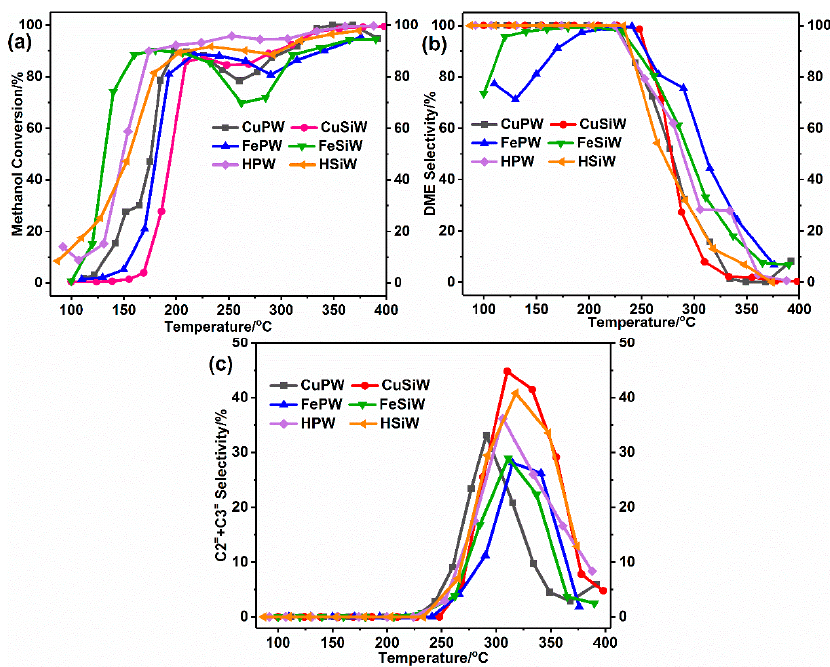
Figure 5. Effluent distribution of temperature programmed conversion of methanol on heteropolyacid salts and heteropolyacids. ( a ) CuPW, ( b ) CuSiW, ( c ) FePW, ( d ) FeSiW, ( e ) HPW, ( f ) HSiW, m cat = 3.00 g, N 2 flow rate = 20 mL/min, WHSV = 0.25 h − 1 .